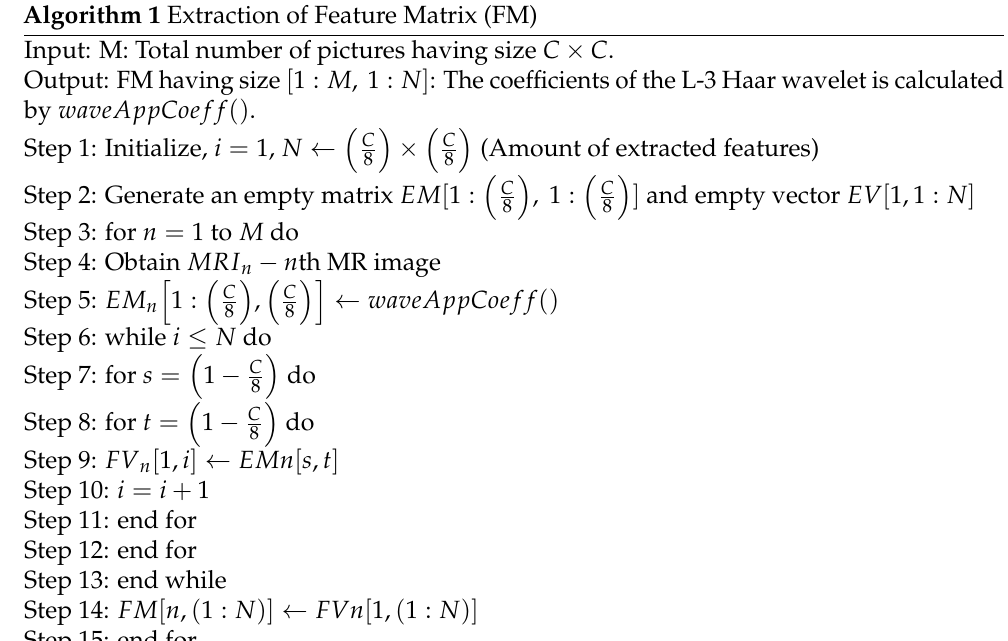
Algorithm 1 Extraction of Feature Matrix